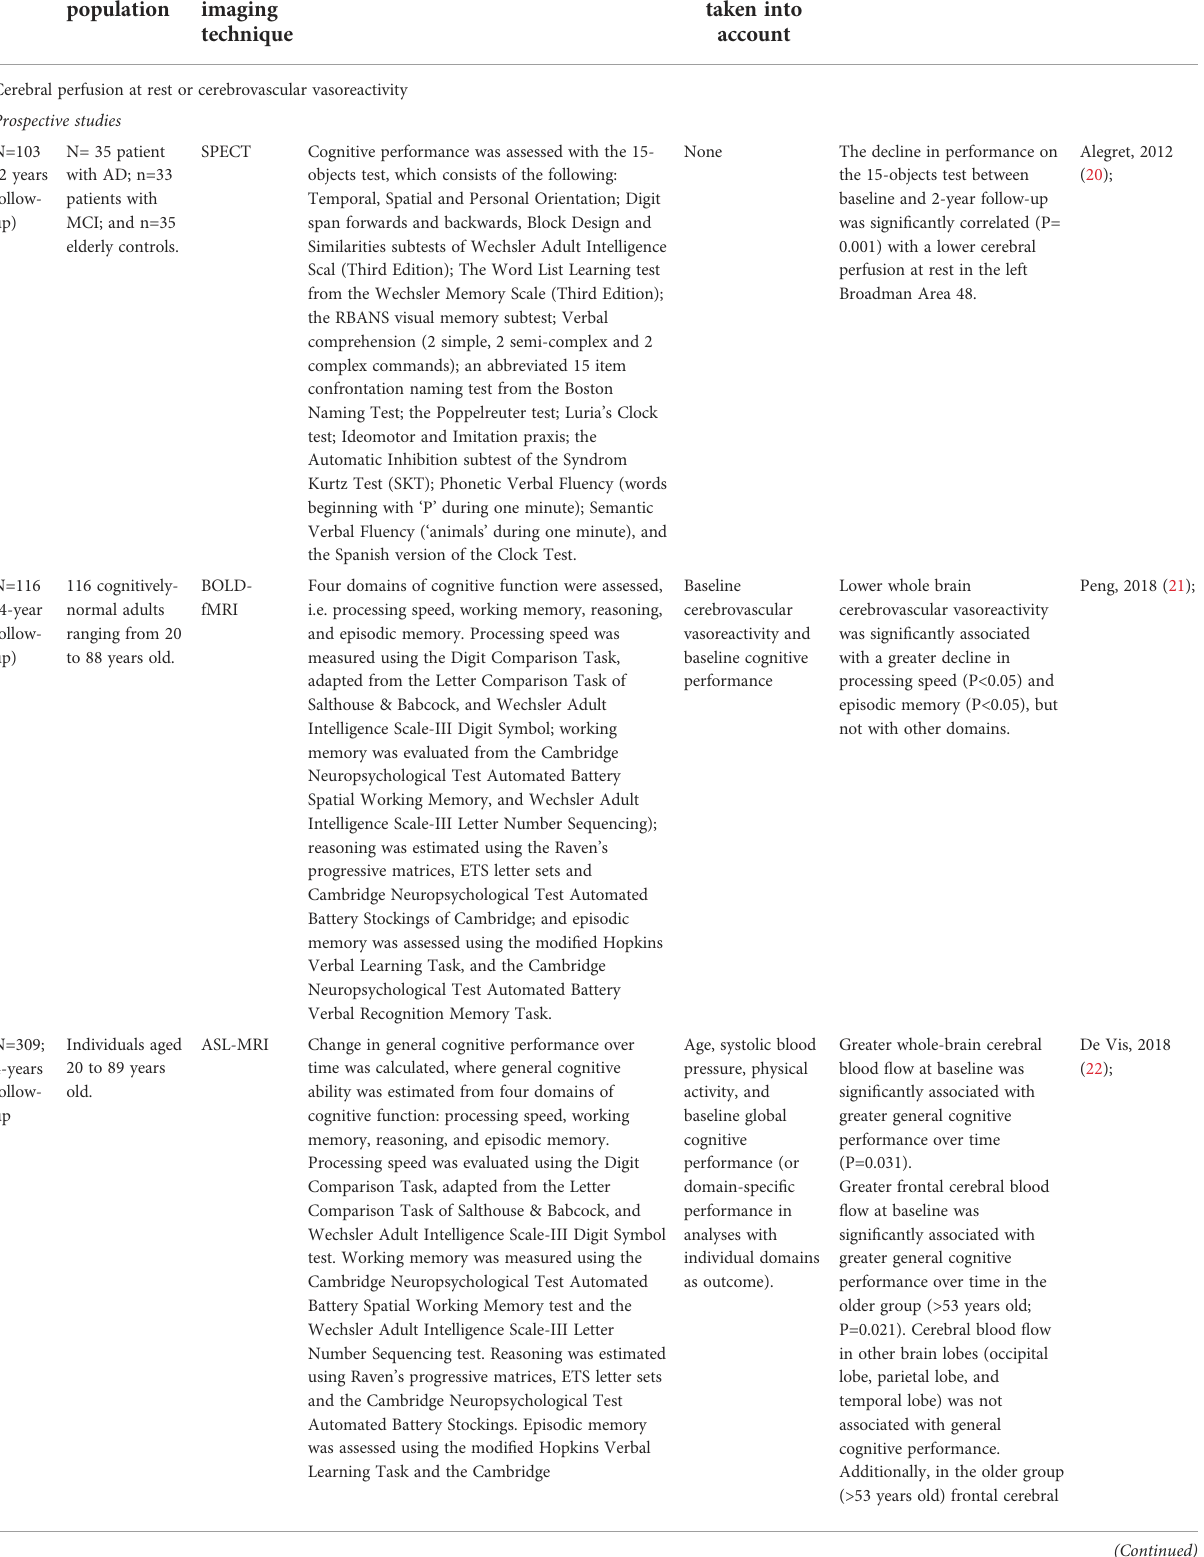
TABLE 1 Association of dysfunction of the neurovascular coupling unit, as quanti fi ed by cerebral imaging, with cognitive performance.